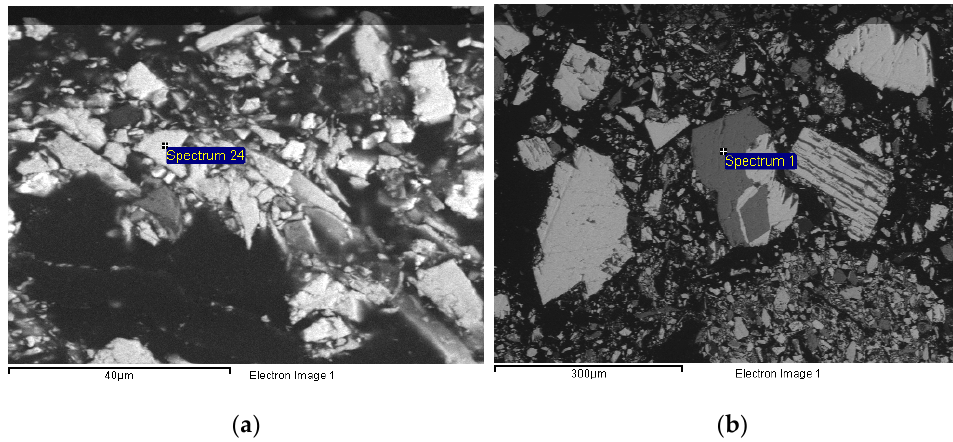
Figure 2. SEM images of galena concentrate: ( a ) boulangerite (Spectrum 24); ( b ) arsenopyrite (Spectrum 1).